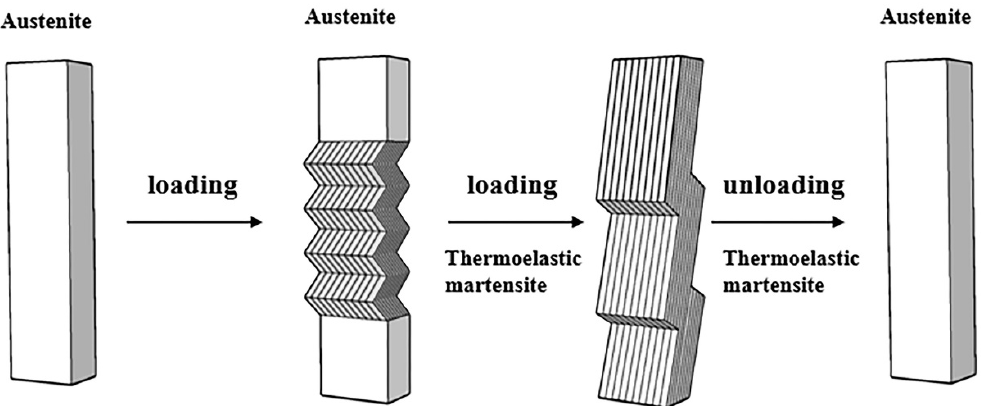
Figure 3. Schematic diagram of the thermoelastic martensitic transformation process in superelastic alloys.